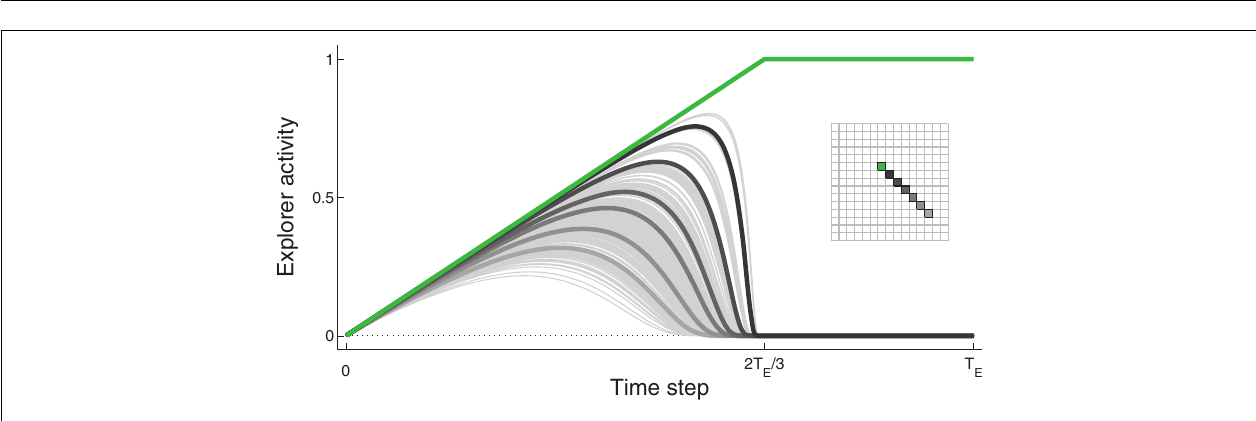
drawn with thick lines in different shades of gray so as to demonstrate the spatial influence on excitation pattern. All other neurons are drawn in thin gray